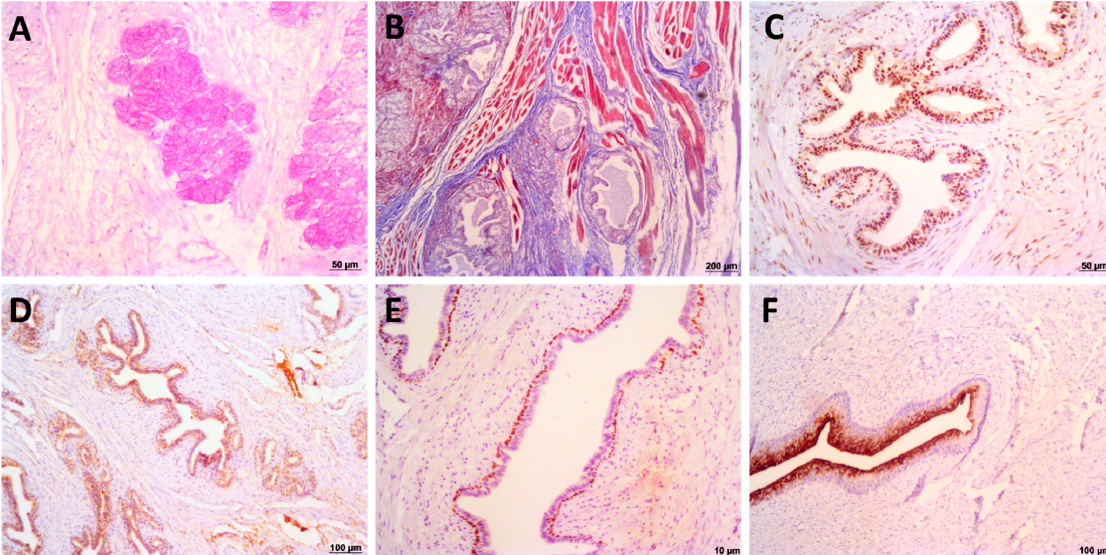
Figure 5. Histochemical and Immunohistochemical analysis of giant anteater prostate gland. ( A ): luminal cells from peripheral zone presenting PAS-rich secretory cells. ( B ): Masson’s trichrome stain, presenting muscle fibers staining in red and collagen fibers stained in blue. It is possible to note a fibromuscular stroma in peripheral zone. ( C ): androgen receptor (AR) nuclear immunoexpression in prostatic epithelial cells. ( D ): prostatic specific antigen (PSA) staining in prostatic epithelial cells. ( E ): p63 positive expression by basal prostatic cells. ( F ): uroplakin III immunoexpression by urothelial superficial cells from prostatic urethra.